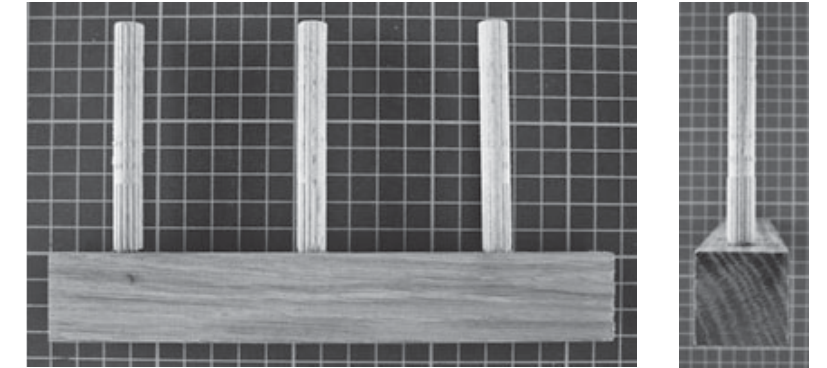
Figure 1 Test sample: Oak dowels welded perpendicular to the fi bre orientation (RT) Slika 1. Ispitni uzorak hrastovine, moždanici zavareni okomito na smjer vlakanaca (RT)